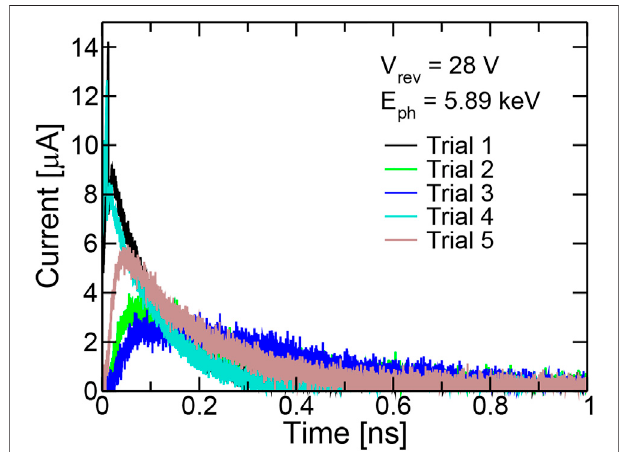
FIGURE 12 | Sample waveforms (absorption of photons with energy 5.89 keV) obtained with the RPL algorithm for a SAM-APD with a structure as in Figure 2 . At the considered bias, the gain is M = 4.7 and the excess noise factor is F = 3.05.